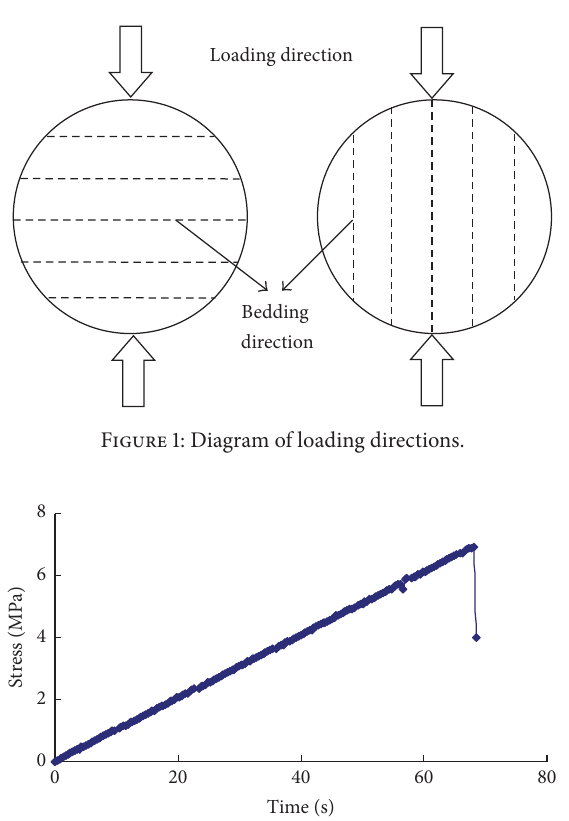
Figure 2: Stress-time